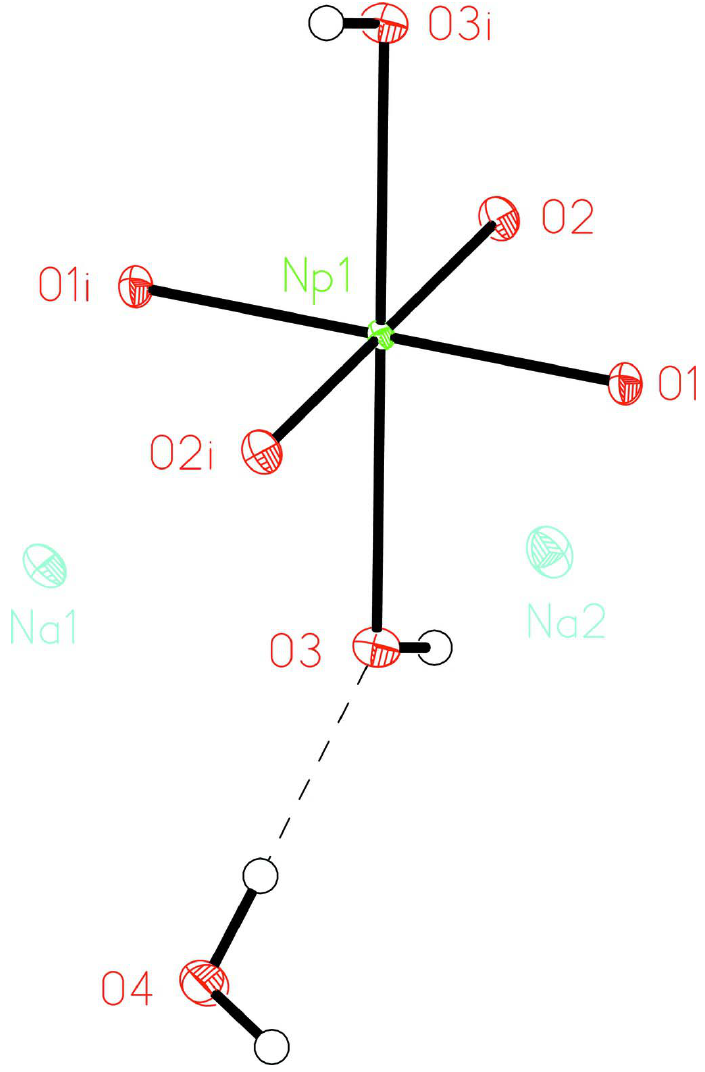
Figure 1 A view of (I), showing the atom-labelling scheme. Displacement ellipsoids are drawn at the 50% probability level and H atoms are represented by circles of arbitrary size. Dashed line indicates the hydrogen-bonding interaction. [Symmetry code: (i) 1 - x , 1 - y , 1 - z